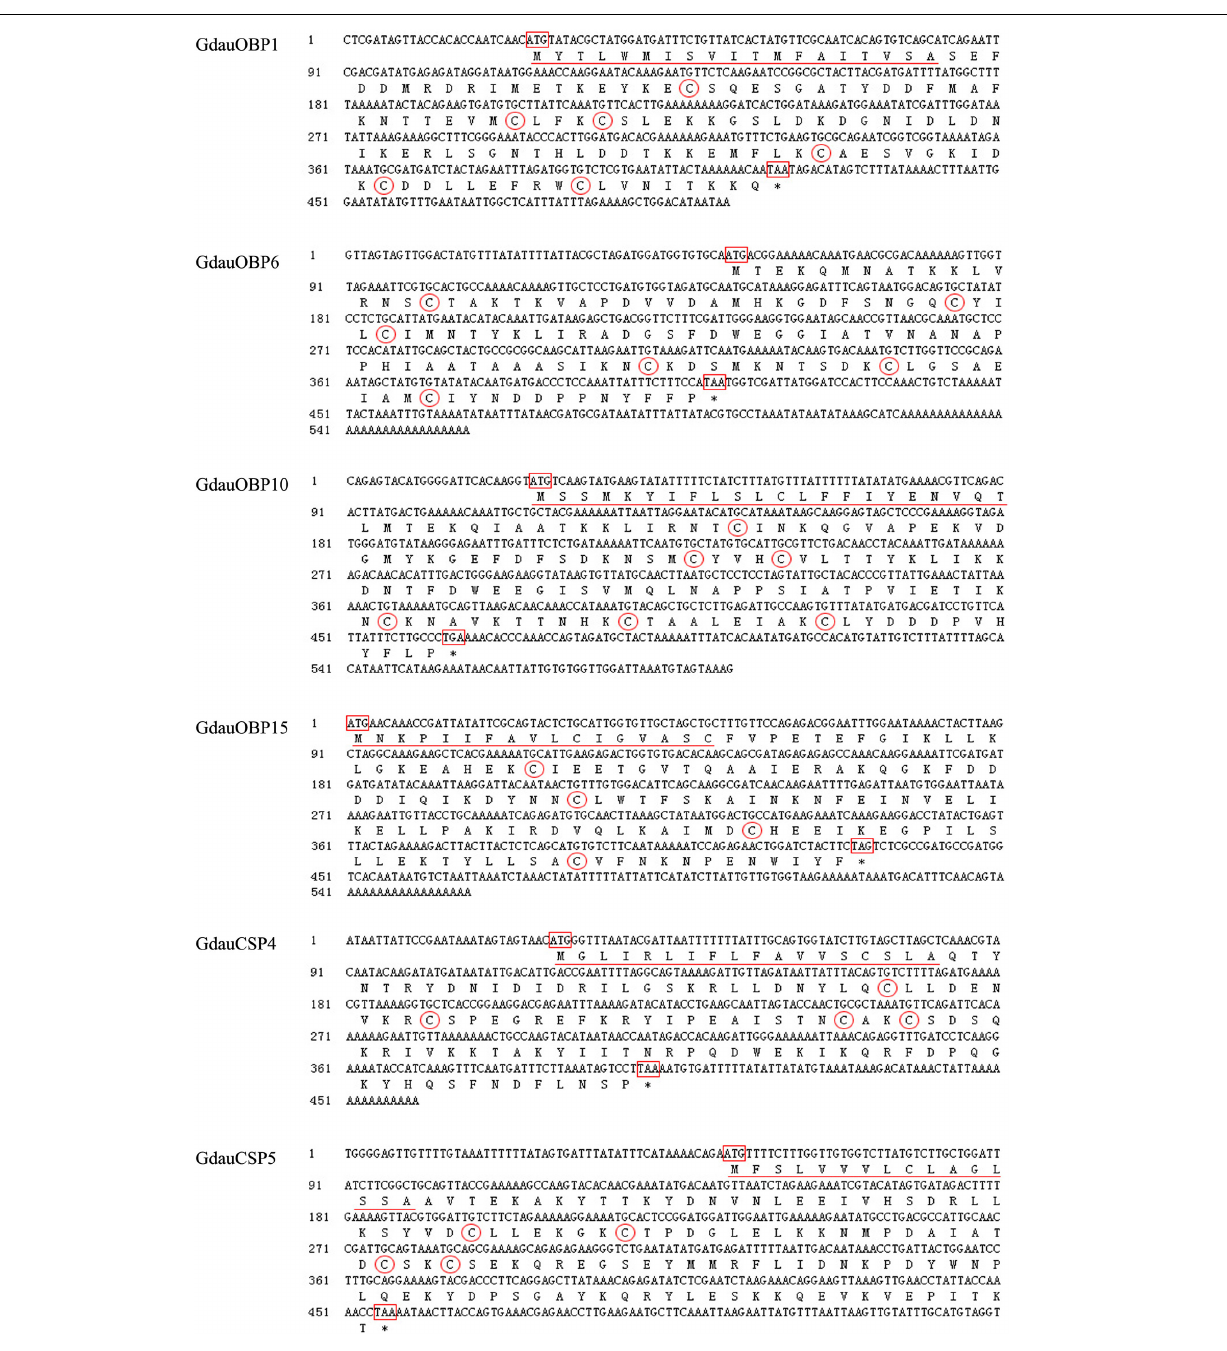
FIGURE 1 | Nucleotide and amino acid sequences of GdauOBP1 , GdauOBP6 , GdauOBP10 , GdauOBP15 , GdauCSP4 , and GdauCSP5. The start and stop codons are boxed, signal peptide is underlined, conversed cysteine residues are circled, and asterisks indicate the termination of